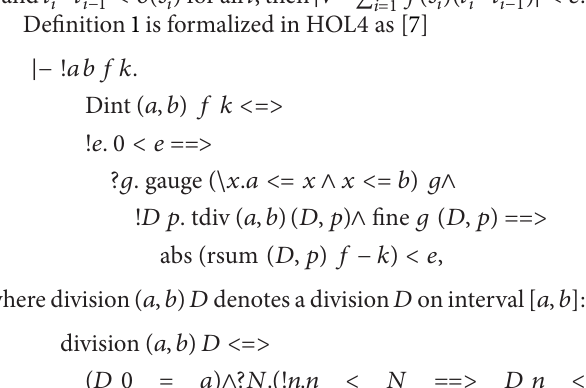
Table 1: Some HOL4 notations and their semantics. Meaning HOL